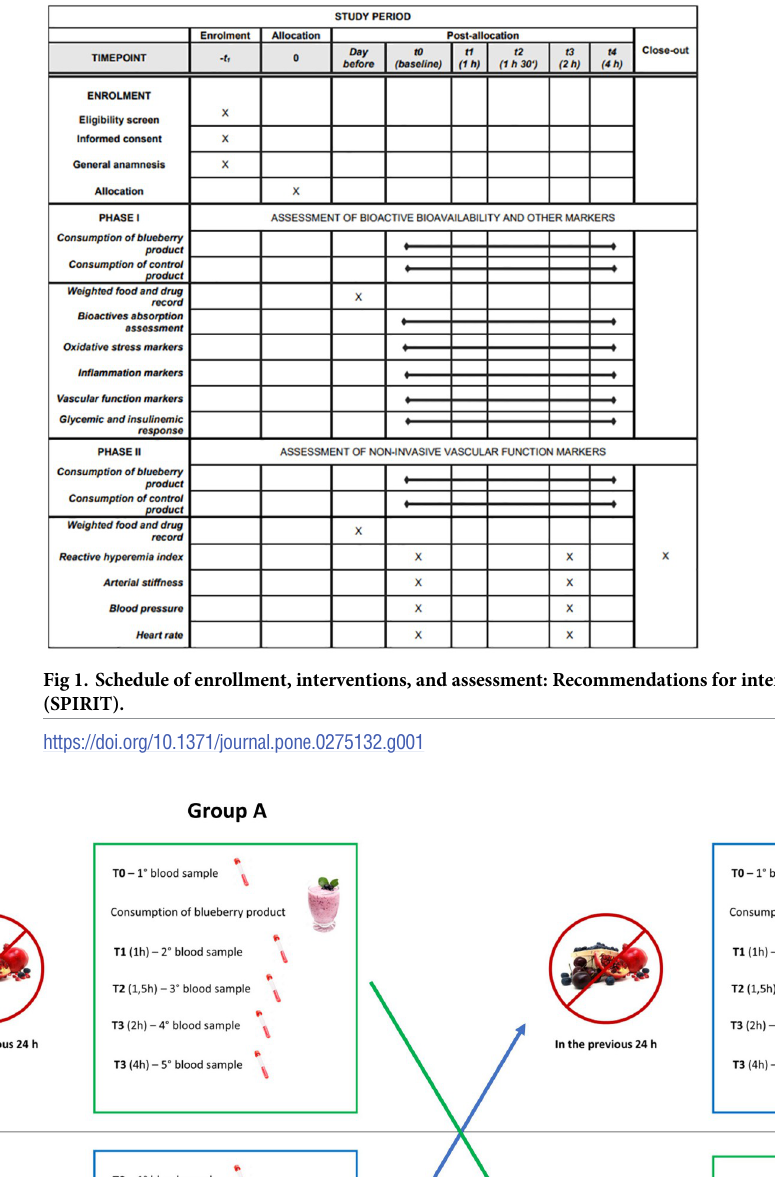
PLOS ONE | https://doi.org/10.1371/journal.pone.0275132 December1, 2022 3 /